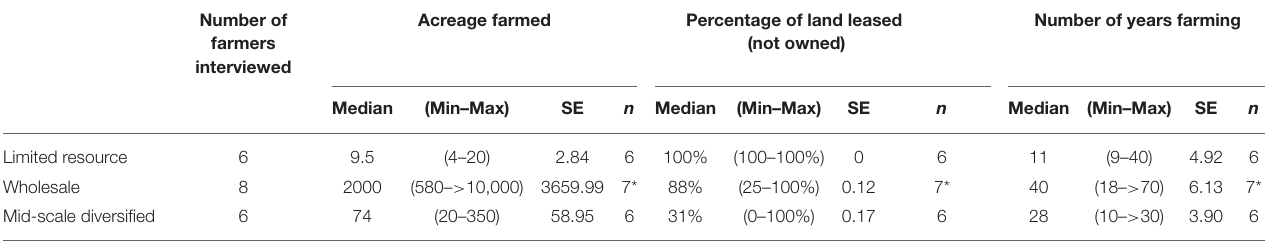
TABLE 1 | Descriptive statistics of interviewed farmers.